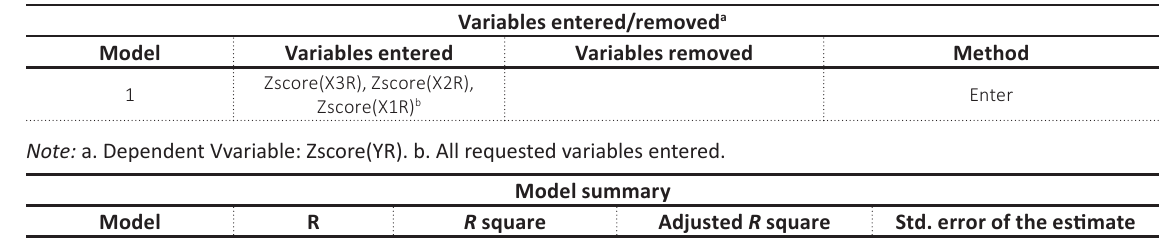
Table B1. Multiple linear regression